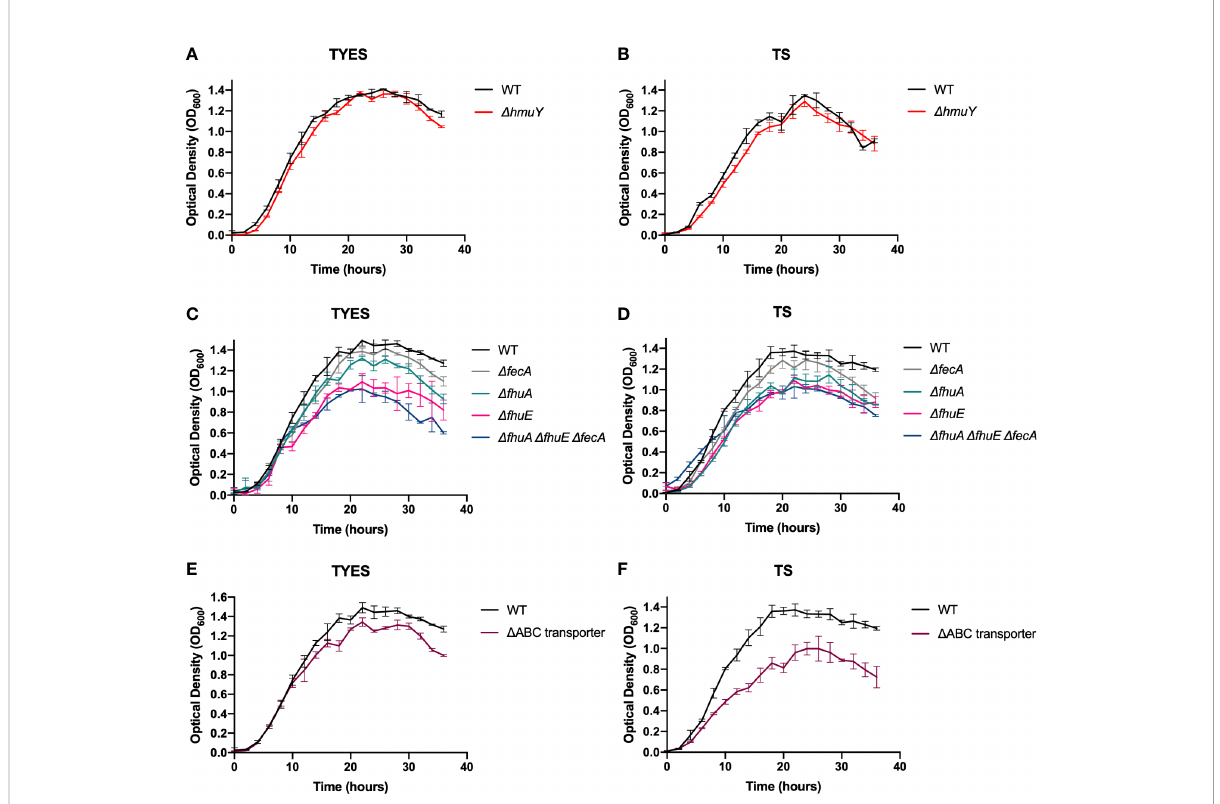
FIGURE 2 Growth of F. columnare wild type (WT) and iron mutant strains in iron-rich (TYES) and iron-limited (TS) medium. D hmuY mutant grown in TYES (A) and in TS (B) . D fecA, D fhuA, D fhuE , and D fhuA D fhuE D fecA mutants grown in TYES (C) and in TS (D) . Signi fi cant differences in peak cell density were seen in TYES between the WT and D fhuA (P < 0.05), WT and D fhuE (P < 0.0001), WT and D fhuA D fhuE D fecA (P < 0.0001). Signi fi cant differences in peak cell density were seen in TS between the WT and D fhuA (P < 0.001), WT and D fhuE (P < 0.0001), WT and D fhuA D fhuE D fecA (P < 0.0001). D ABC transporter mutant grown in TYES (E) and in TS (F) . Signi fi cant differences in peak cell density were seen in TS between the WT and D ABC transporter mutant (P < 0.0001). Wild type (WT) was included as a control in each experiment. Strains were grown at 28°C with shaking (200 rpm) and measurements were taken every two hours for 36 hours. Error bars represent standard error of the